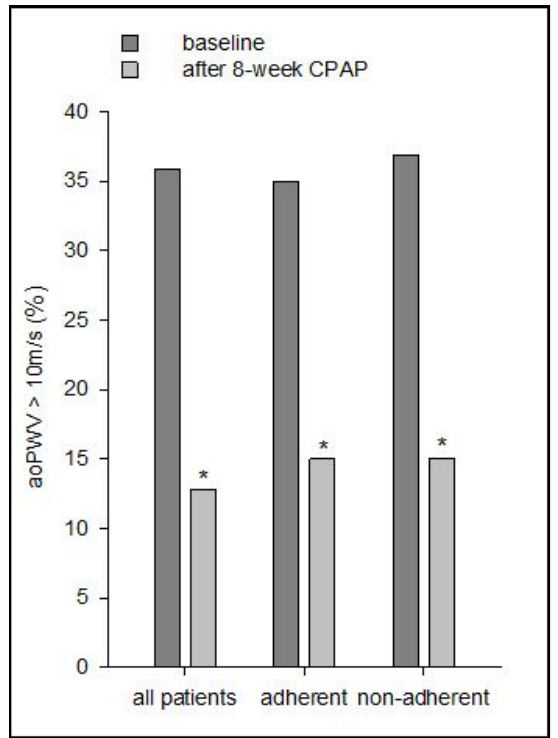
Figure 3. The prevalence of patients with aoPWV > 10 m/s at baseline and after 8-week CPAP therapy in the study population. aoPWV: aortic pulse wave velocity; CPAP: continuous positive airway pressure; *: p < 0.00001 vs. baseline.